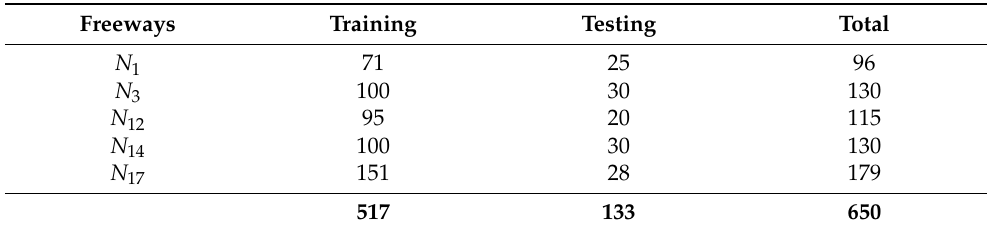
Table 2. The Breakdown of the traffic datasets collected from the freeways used for the ANFIS-PSO model training and